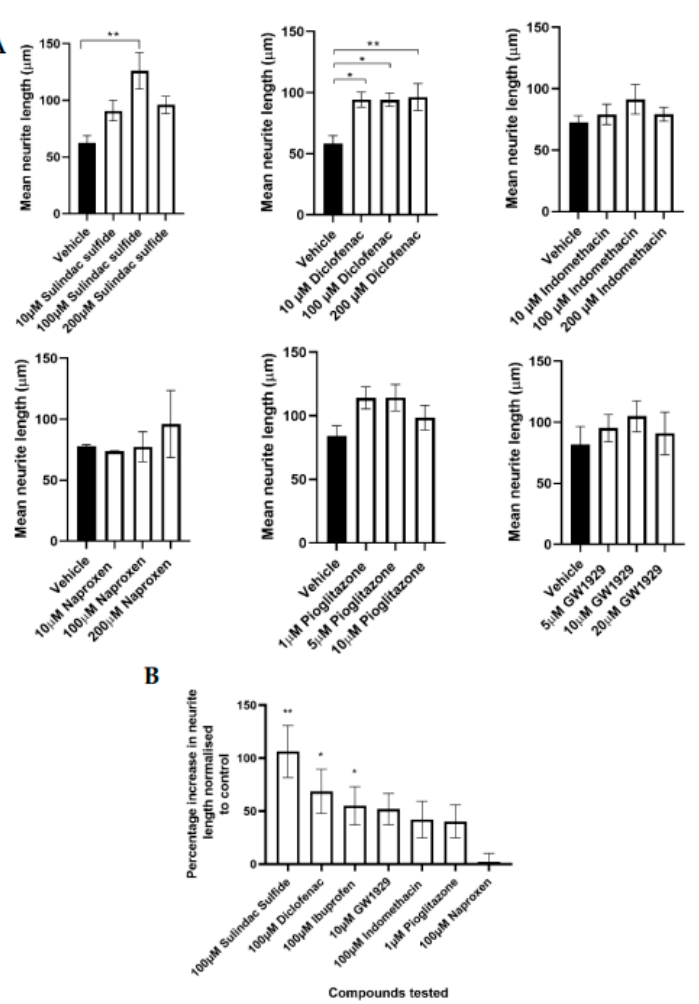
Figure 1. PC12 neuronal cells were seeded upon EngNT containing SCL4.1/F7 Schwann cells. ( A ) Significant increases in neurite length were seen in the presence of 10 µM, 100 µM, and 200 µM diclofenac and 100 µM sulindac sulfide compared to the vehicle control, after 72 h exposure. ( B ) The percentage increase in neurite length normalised to the control showed that sulindac sulfide had the greatest effect on neurite outgrowth and naproxen the least. Scale bar = 100 µm. N = 6, mean ±